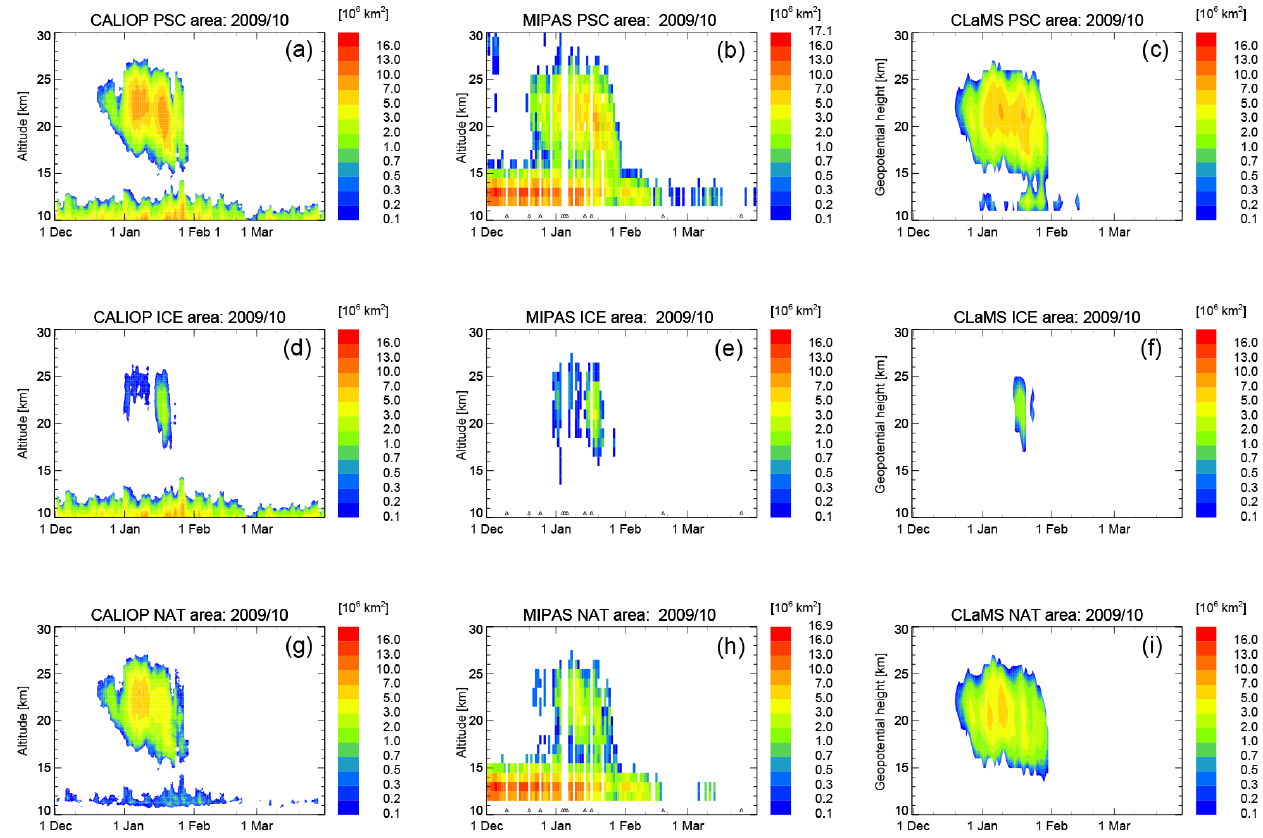
Figure 2. Comparison of PSC areal coverage between CALIOP (v2) (a, d, g) , MIPAS (v1.2.8) (b, e, h) , and CLaMS (c, f, i) from 1 De- cember 2009 until 31 March 2010. Total PSC areal coverage ( A PSC ) in 10 6 km 2 (a, b, c) as well as further classified ice (d, e, f) and NAT PSCs (g, h, i) are presented as a function of time and altitude throughout the 2009/2010 NH winter. MIPAS observations and CLaMS simu- lations are restricted to latitudes < 82 ◦ N. PSC thresholds for CLaMS simulations are as follows: STS, 3.3µm 2 cm − 3 ; NAT, 0.25µm 2 cm − 3 ; ice, 0.5µm 2 cm − 3 . Black triangles in the time series of the measurements indicate data gaps. Please note that the color code is always identical except for the maximum value of the top color